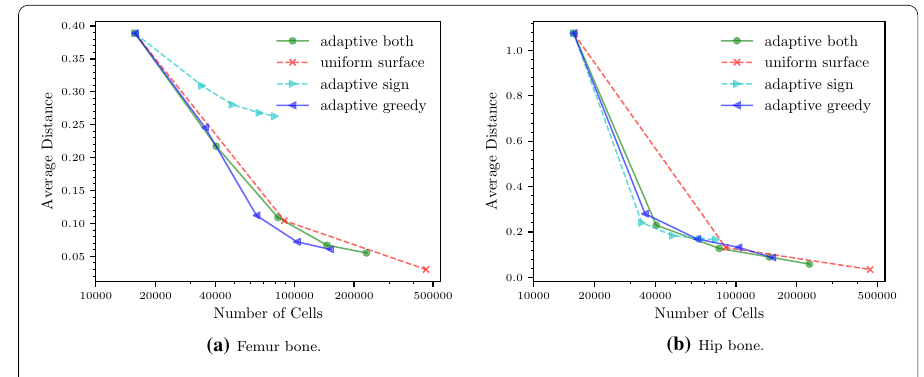
Fig. 8 Comparison of different adaptive refinement strategies in terms of average distance value for the femur bone level set function (a ) and the hip bone level set function ( b )